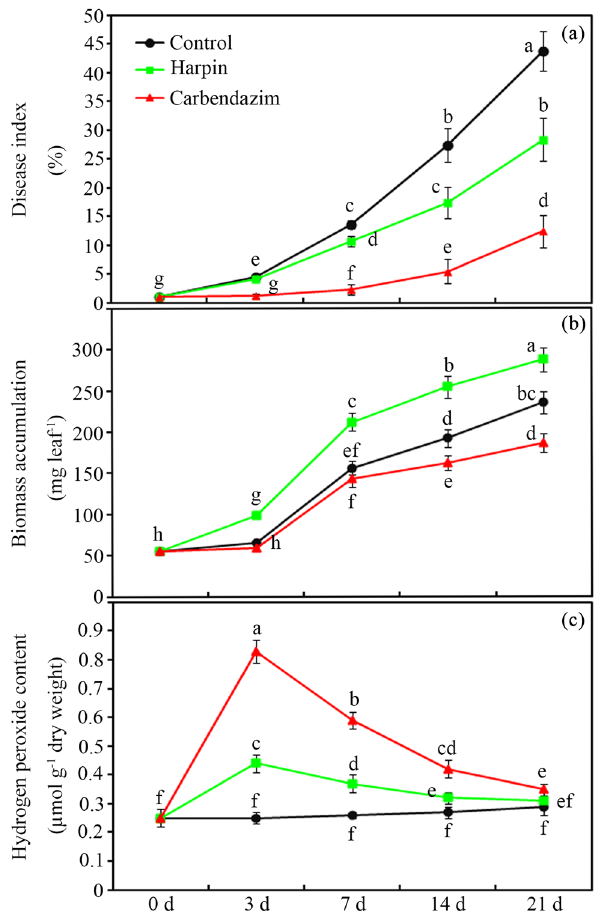
Figure 1: E ff ects of pesticides on DI, leaf growth, and H 2 O 2 content. E ff ects of harpin ( 30 mg L − 1 ) and carbendazim ( 1,000 mg L − 1 ) on DI ( a ) , biomass accumulation ( b ) , and H ( c ) of jujube leaves 2 O 2 content after treatment for 0, 3, 7, 14, and 21 days. Bars represent the standard deviations of the means ( n = 3 ) . Numbers with the same letter were not signi fi cantly di ff erent ( p < 0.05 )